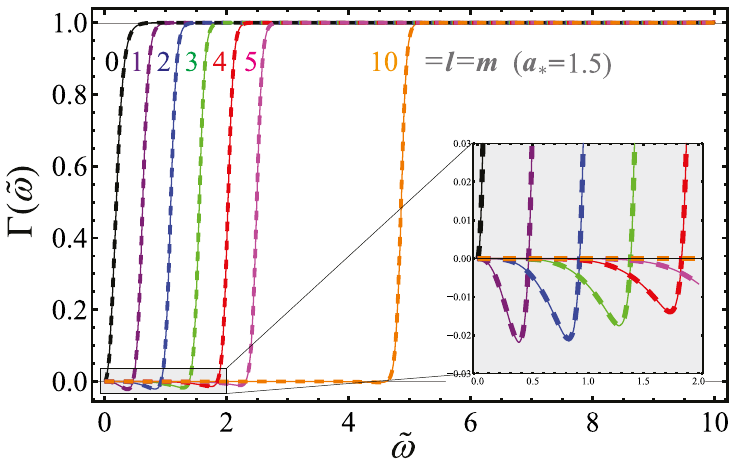
Figure 2 . Greybody factor curves of exact solutions (thin solid lines) and those of numerical results (dashed lines) are compared for l = m modes with a (cid:3) = a (cid:3) max